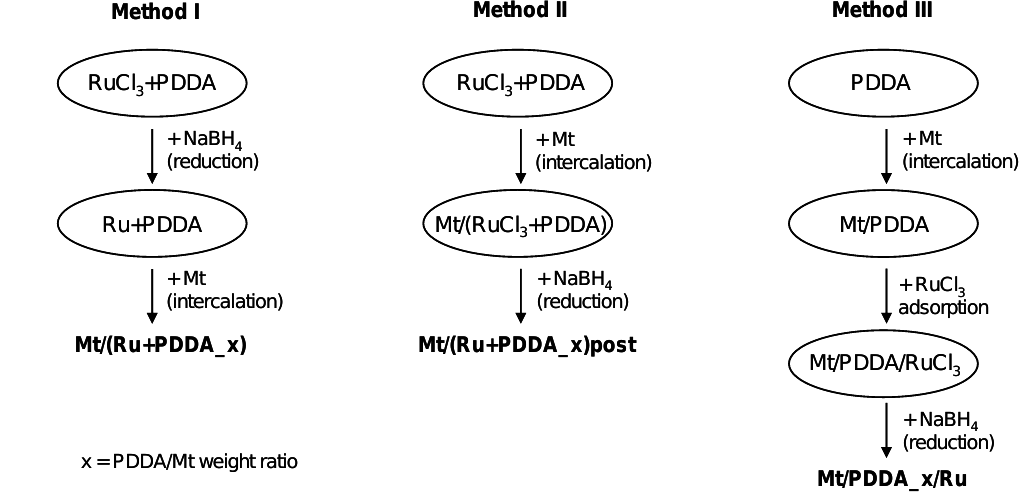
Figure 1. Schematic illustration of catalysts synthesis methods.